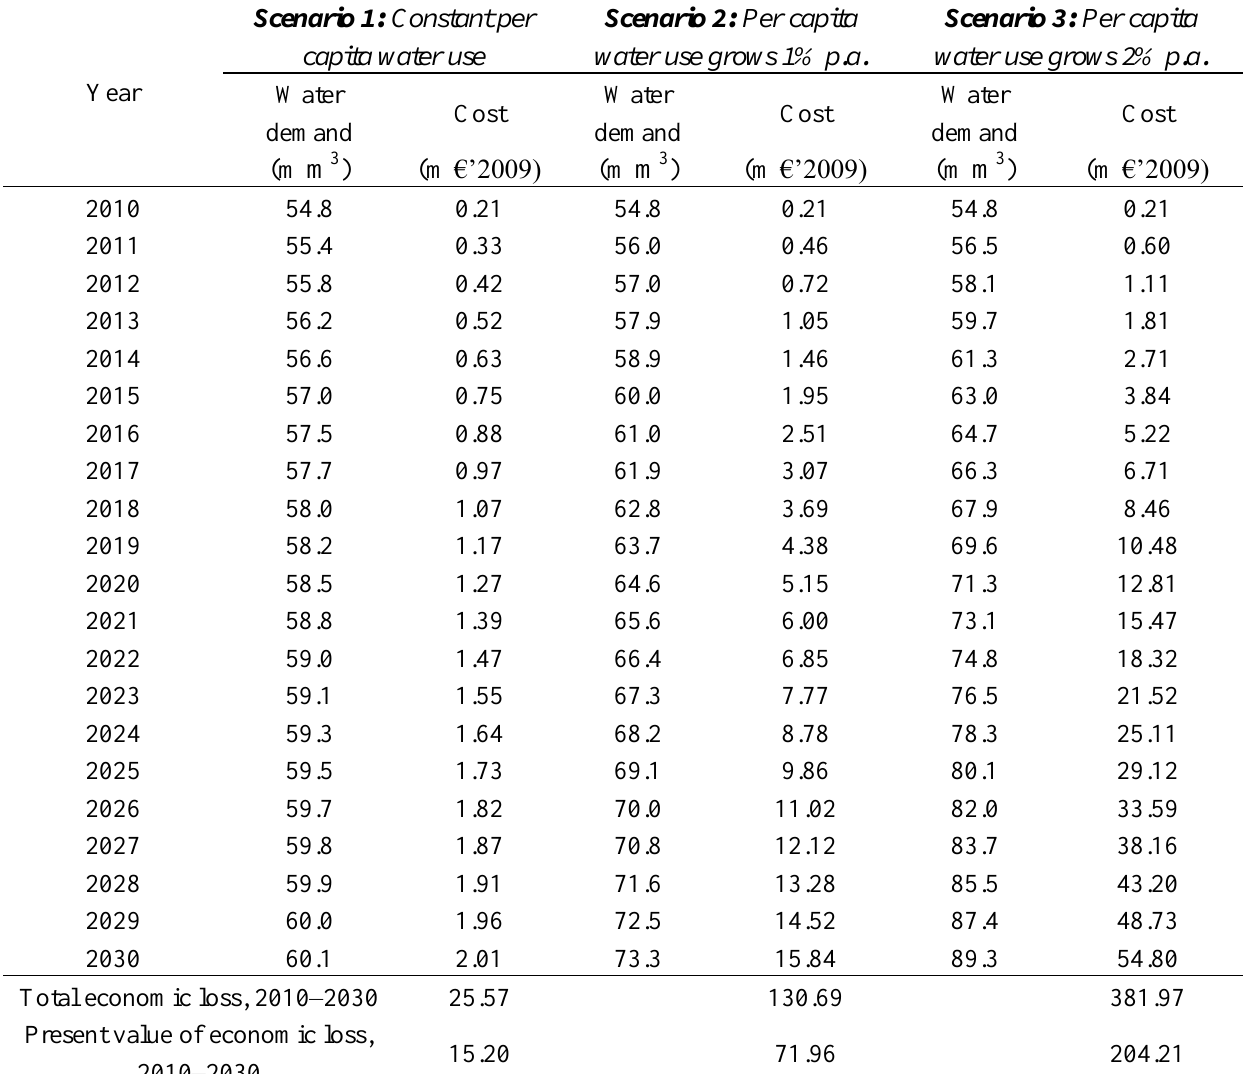
Table 1. Annual costs of residential water shortages in